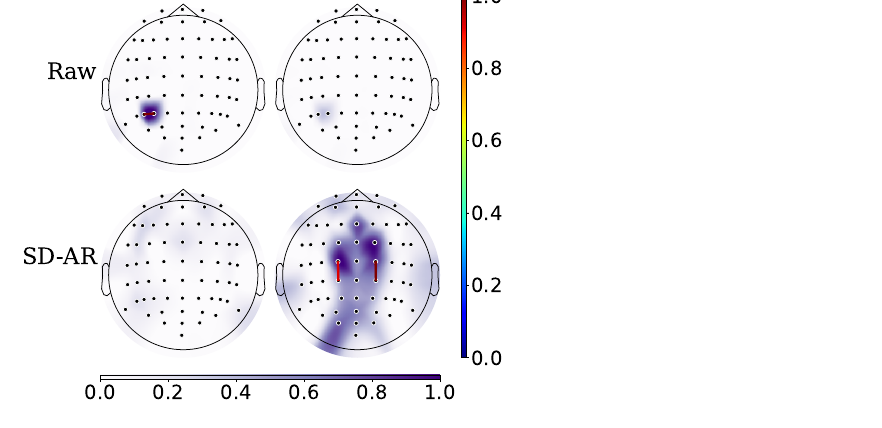
Figure 7. Topographical maps of # sbj45 with poor skills, having a high gain in classifier accuracy provided by SD-AR